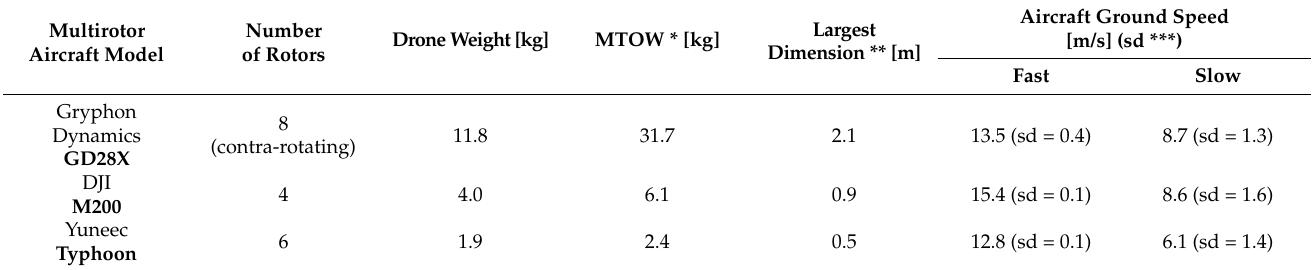
Table 1. Overview of Drones Tested by Volpe. Adapted with permission from Ref. [18].